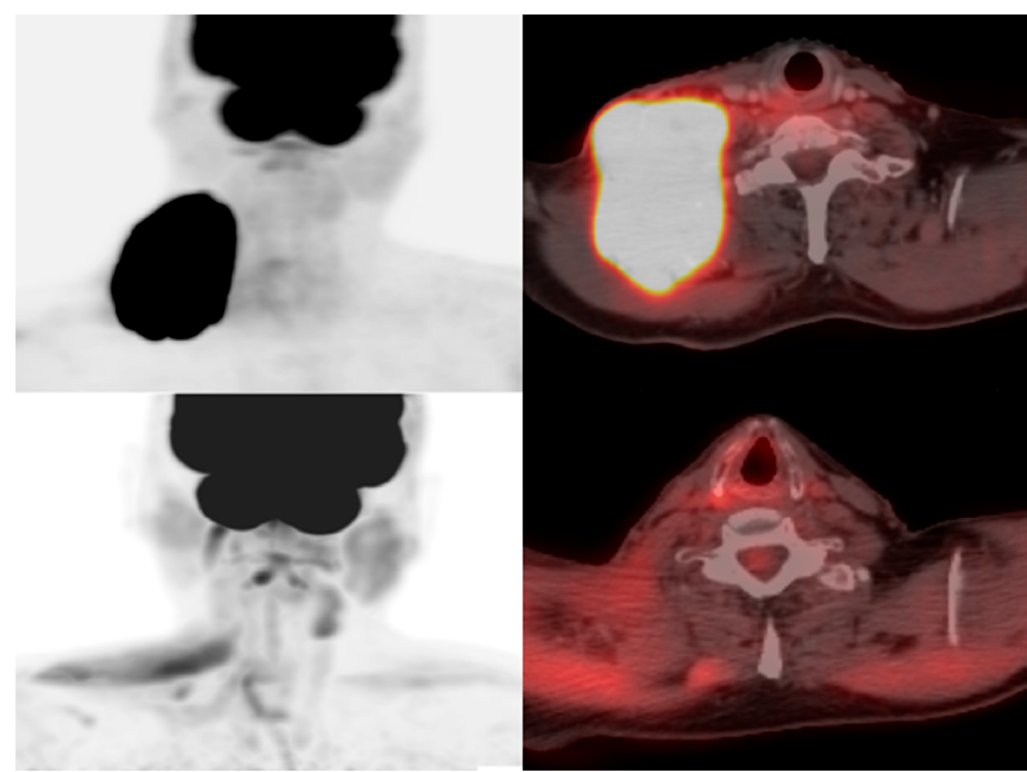
Figure 3. A 73-year-old man with diffuse large B-cell lymphoma. Maximum intensity projection and axial fused FDG PET/CT pre- (above) and 28 days post- (below) CAR T-cell therapy demonstrating resolution of hypermetabolic adenopathy in the right lower neck consistent with complete meta- bolic response.